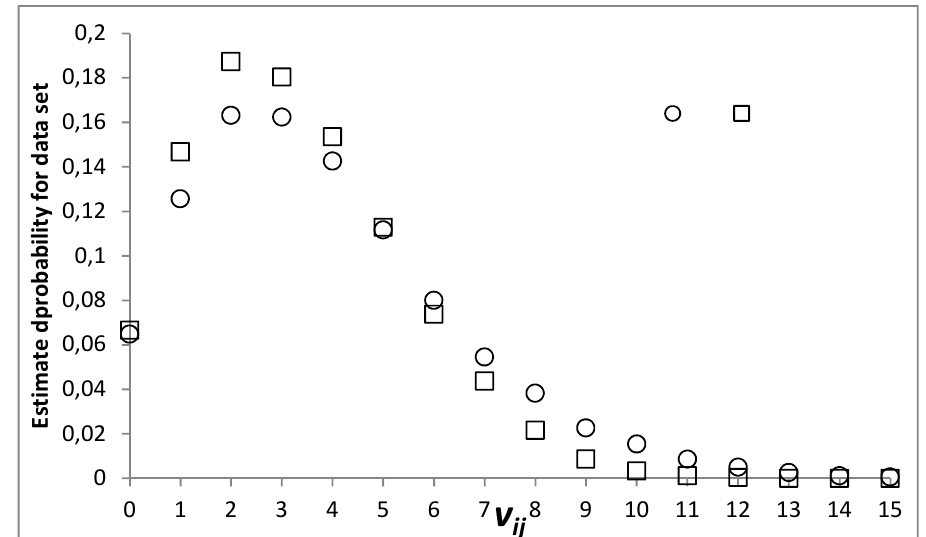
Figure 4. Nested Monte Carlo estimation of the probability for getting different v 2,2 values in a re-sampled data set, where in total 53 recordings are made of pollinator species 2 (to estimate p 2,2 ) and 14 recordings are made for plant species 2 (to estimate q 2,2